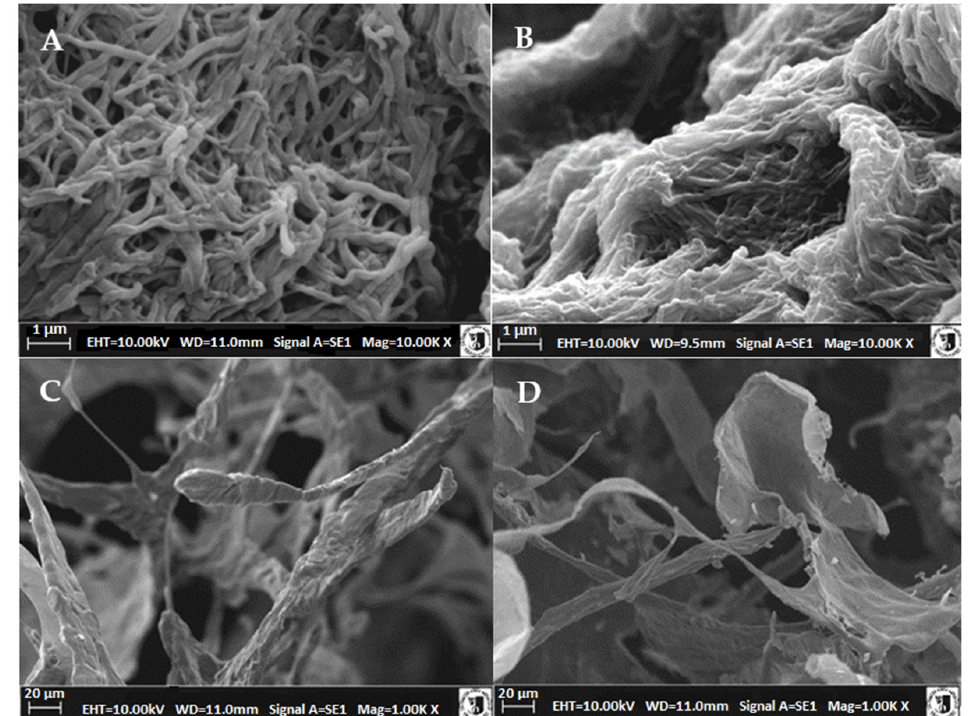
Figure 5 . Electron microgram SEM of ( A ) reconstituted atelocollagen fibers (neutral solution at pH 7.4) isolated from chicken keel cartilage after preliminary proteoglycan extraction with NaCl solution; ( B ) isolated from chicken keel cartilage after extraction with MgCl2 solution; ( C ) freeze-dried preparations of reconstituted collagen fibers obtained in a neutral solution at pH 7.4; isolated from cartilage after preliminary extraction of proteoglycans with NaCl solution; ( D ) from cartilage after extraction of proteoglycans with MgCl2 solution.